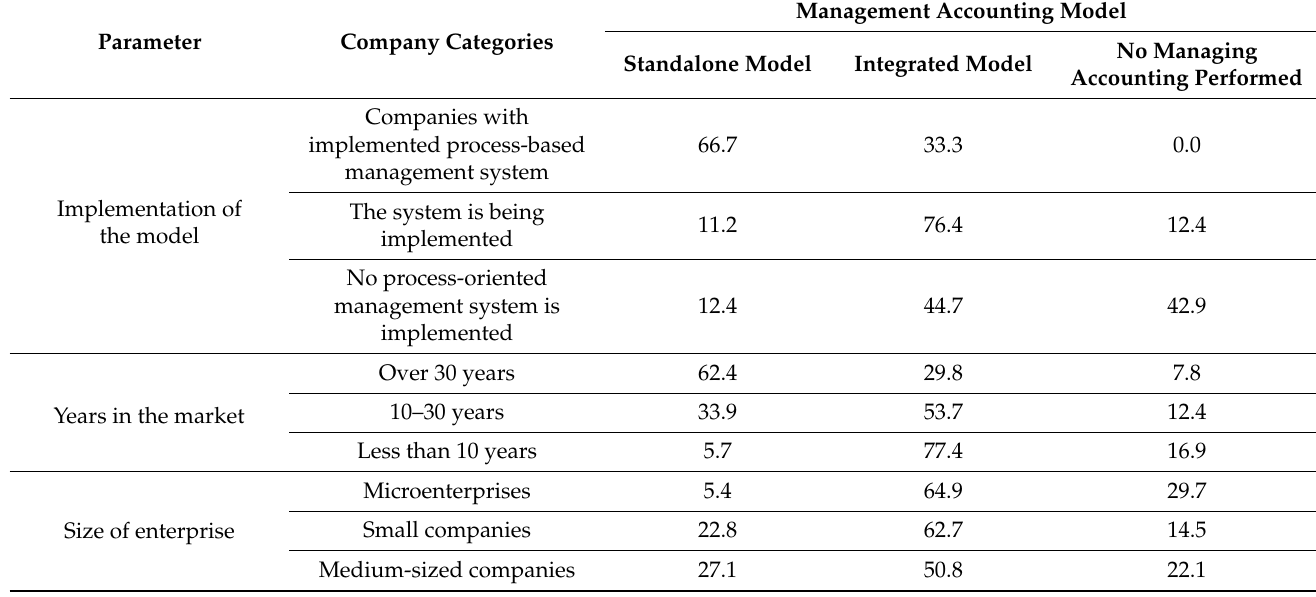
Table 3. Common model of management accounting in different categories of companies (according to the results of experts’